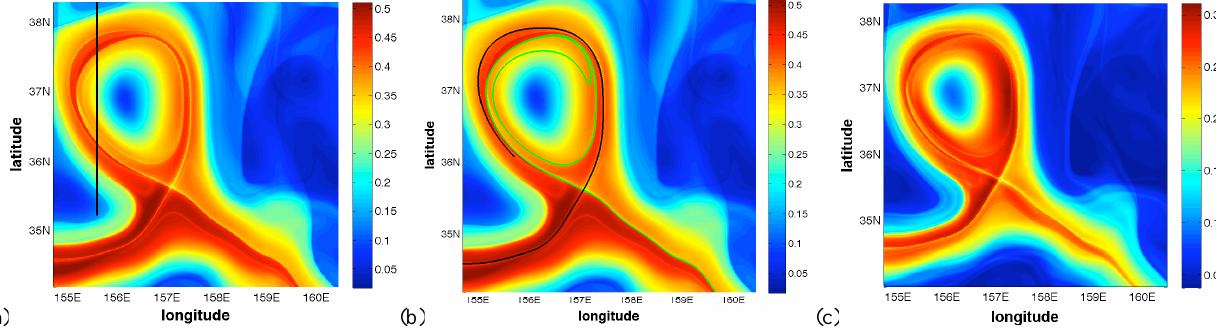
Fig. 3. (a) Contour plot of the function M over a small oceanic area on 2 May 2003 for τ = 15days. The black straight line corresponds to the selection for outputs in Fig. 2 (a) ; (b) the same with a piece of stable manifold (black line) and a piece of unstable manifold (green line) overlapping; (c) the function M for F ( x (t)) = || a ( x (t),t) || and τ = 15 days in the same